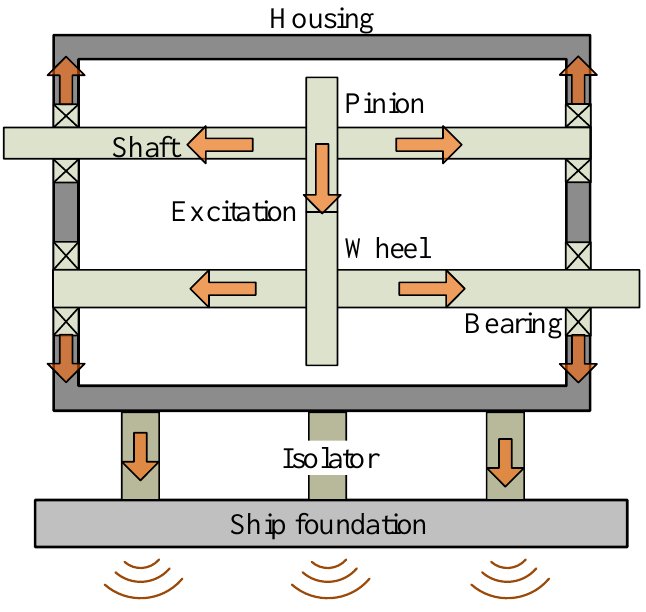
Figure 5. Revised Figure 5. Vibration transfer process.